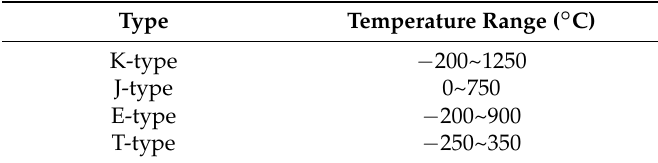
Table 1. Measurable temperature range of various common types of thermocouples